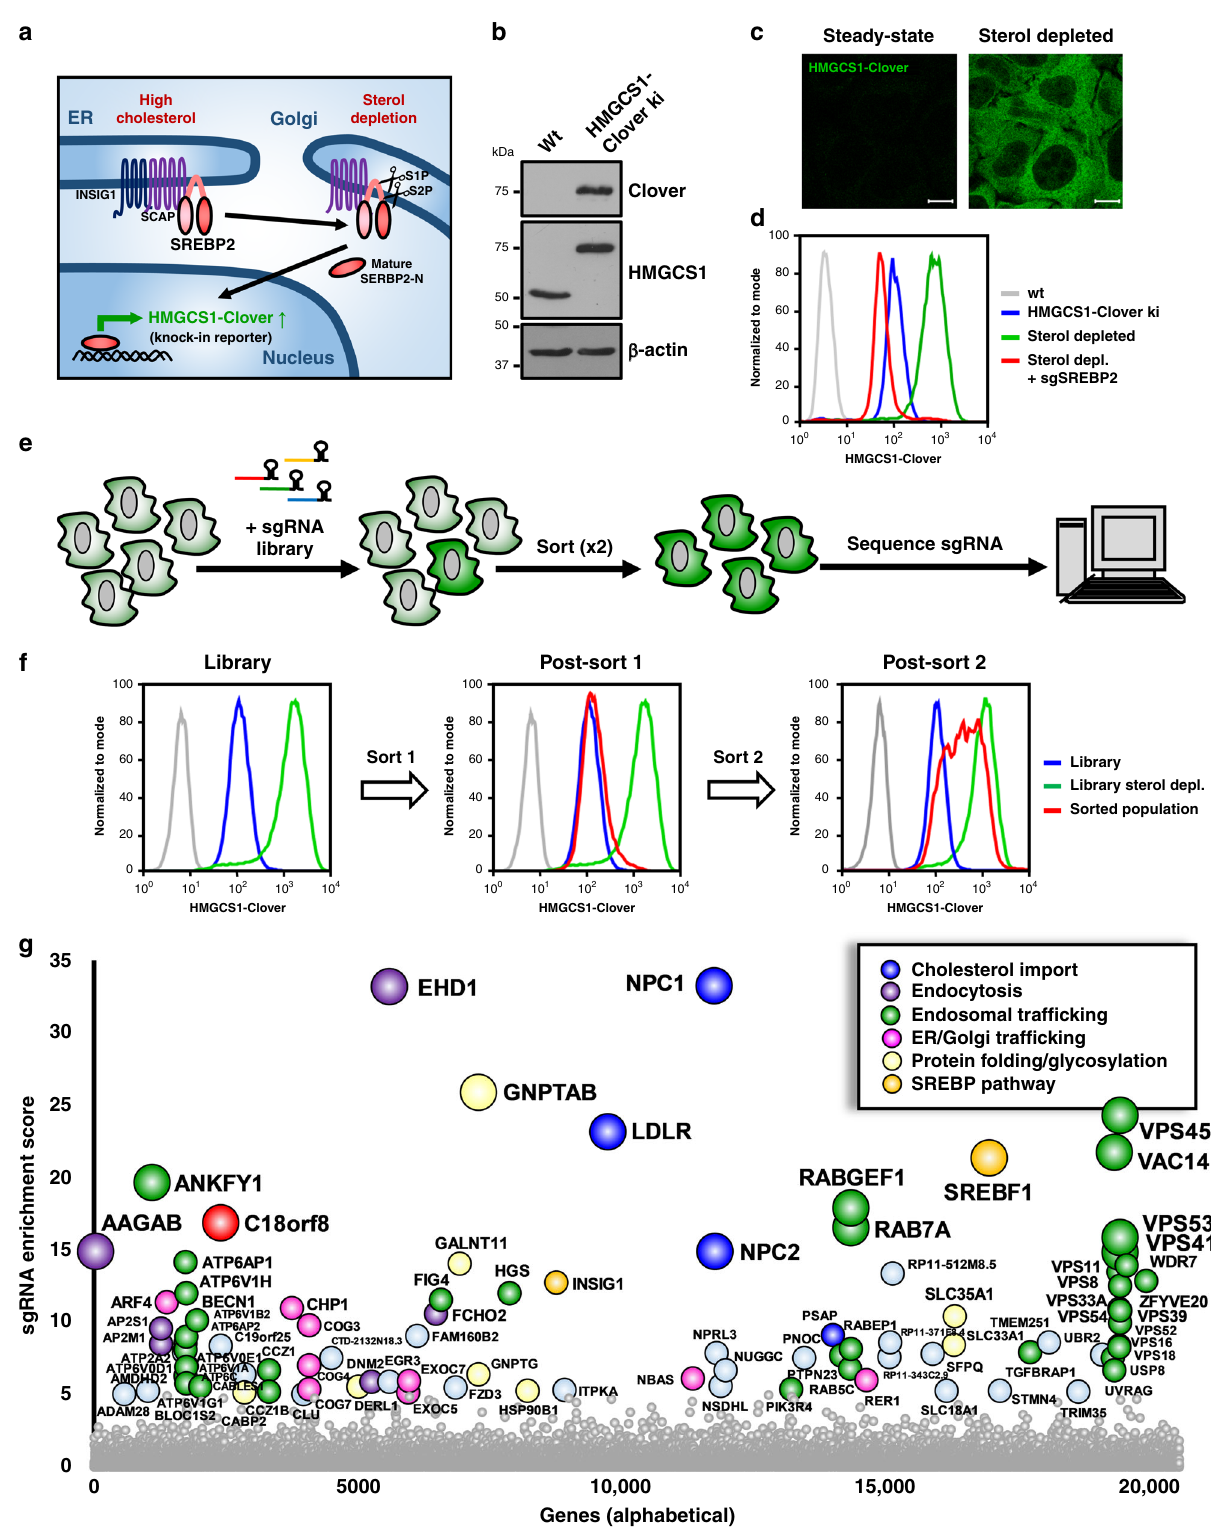
HMGCS1-Clover high phenotype under sterol replete conditions (Fig. 1f). Next-generation sequencing of the population revealed sgRNA enrichment for 93 genes (MAGeCK sgRNA